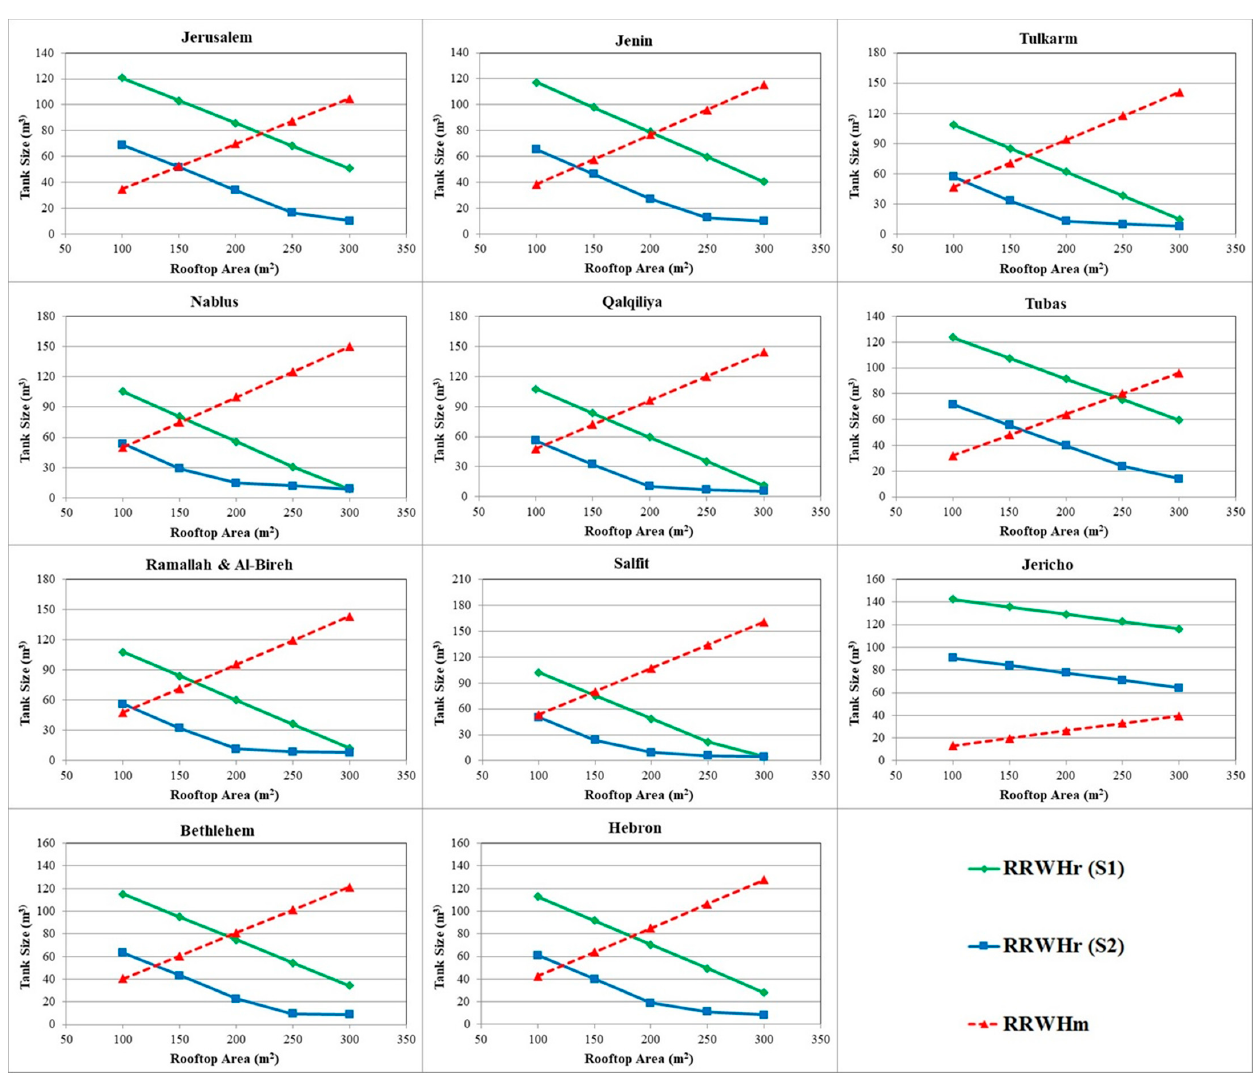
Figure 4. RRWHr and RRWHm versus different rooftop areas in the different governorates for S1 and S2 scenarios.